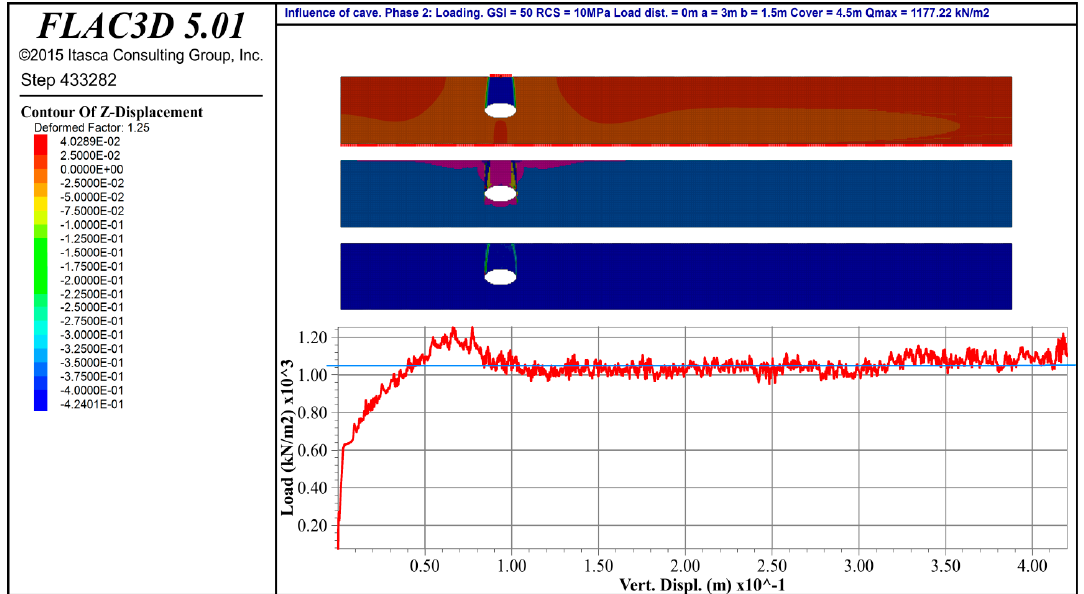
Figure 2. Case IEH-2. Eccentricity E / a = 0 (direct punching shear failure mechanism and vertical cut surfaces). Appl. Sci. 2019 , 9 , x FOR PEER REVIEW